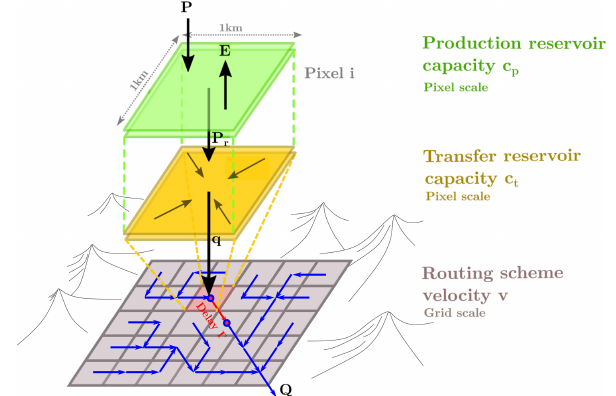
Figure 1. General outlines of the GRD model: P represents the local rainfall over one cell; E is the potential evapotranspiration; P r is the effective rainfall; q is the elementary discharge; and Q is the total routed